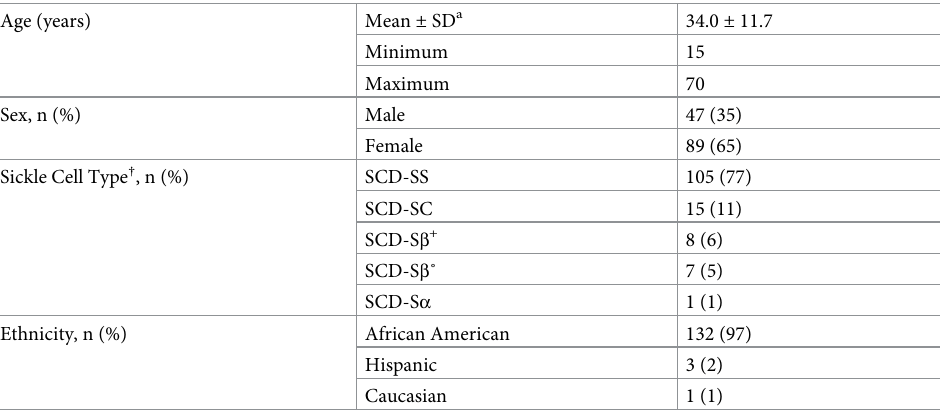
† Sickle cell types: SCD-SS (sickle cell disease-homozygous hemoglobin S, sickle cell anemia), SCD-SC (sickle